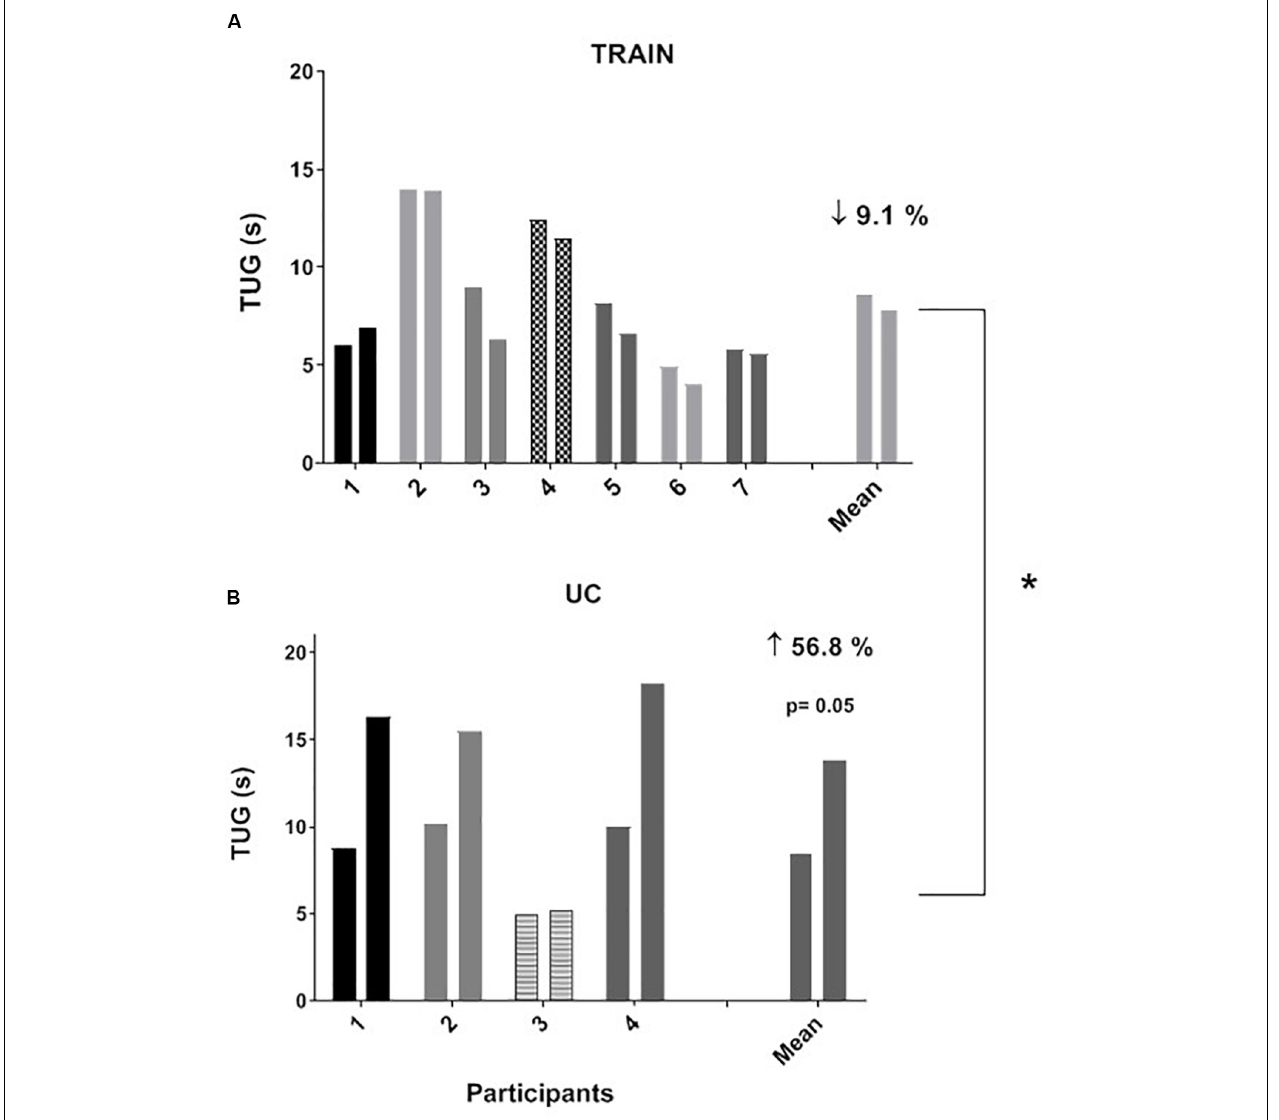
FIGURE 3 | Individual and average values for “Timed Up and Go” test (TUG) before and after 12 weeks of exercise training ( A , TRAIN) and usual care ( B , UC). Average data are expressed as mean + SE. ∗ Significantly different between TRAIN and UC, p <